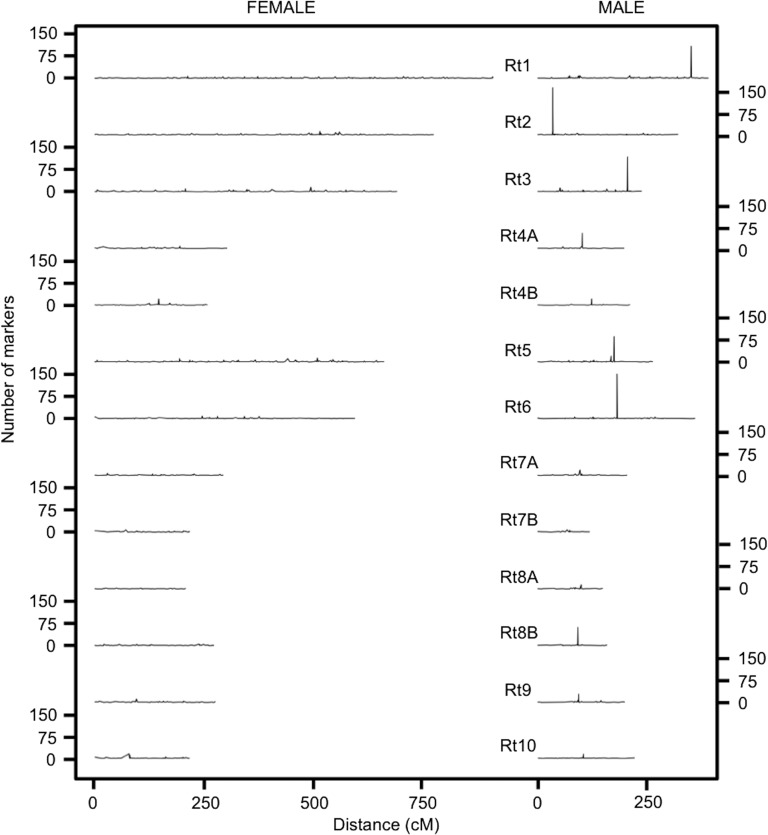
Difference in recombination between sexes. While the female map shows a more uniform recombination rate across all linkage groups, the male map exhibits nonrecombining regions as peaks of high marker density.